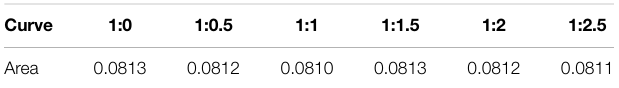
TABLE 4 | Integral areas of different